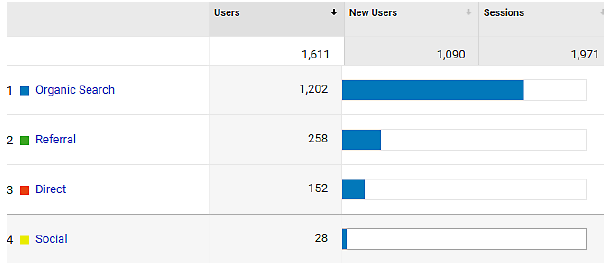
Figure 4. Ways to discover the virtual exhibition (source: created by authors)